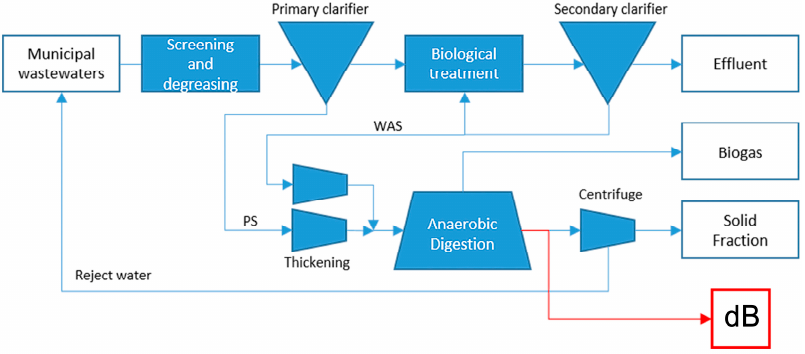
Figure 7. Schematic view of treatment plant producing digestate dB.